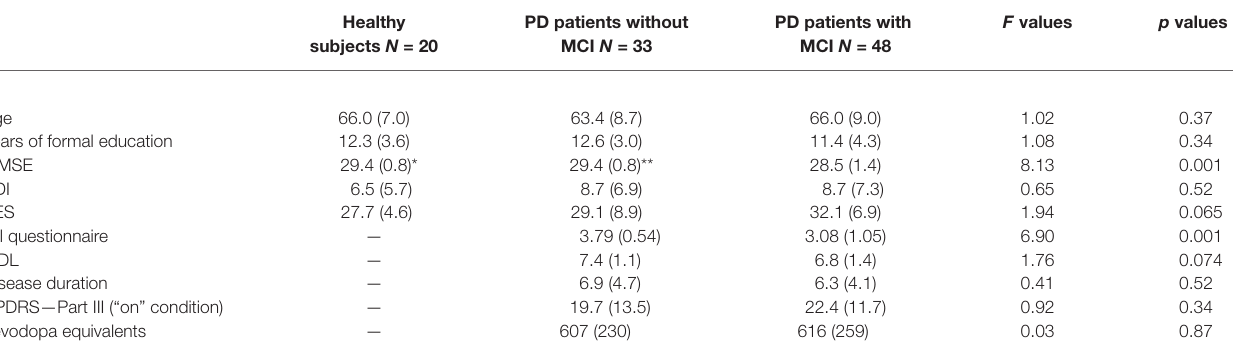
TABLE 1 | Social-demographic and clinical characteristics of the four experimental groups . Healthy PD patients without PD patients with F